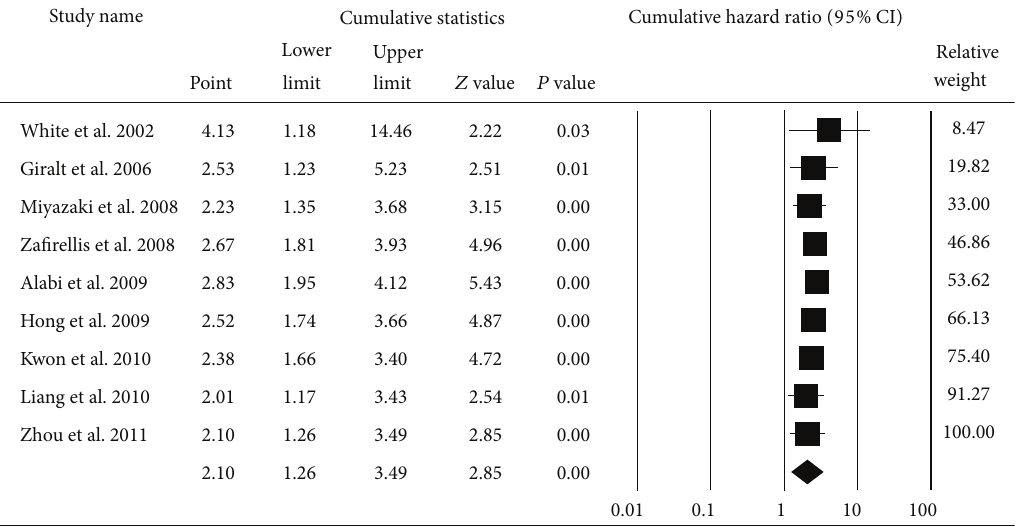
Figure 5: Cumulative meta-analysis for the association between VEGF expression and disease-free survival of CRC.